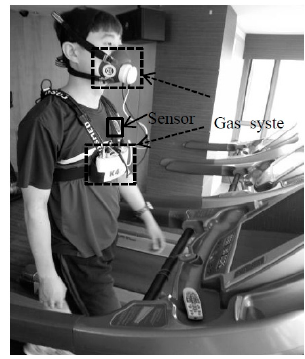
Figure 4. Experimental setup on the treadmill.